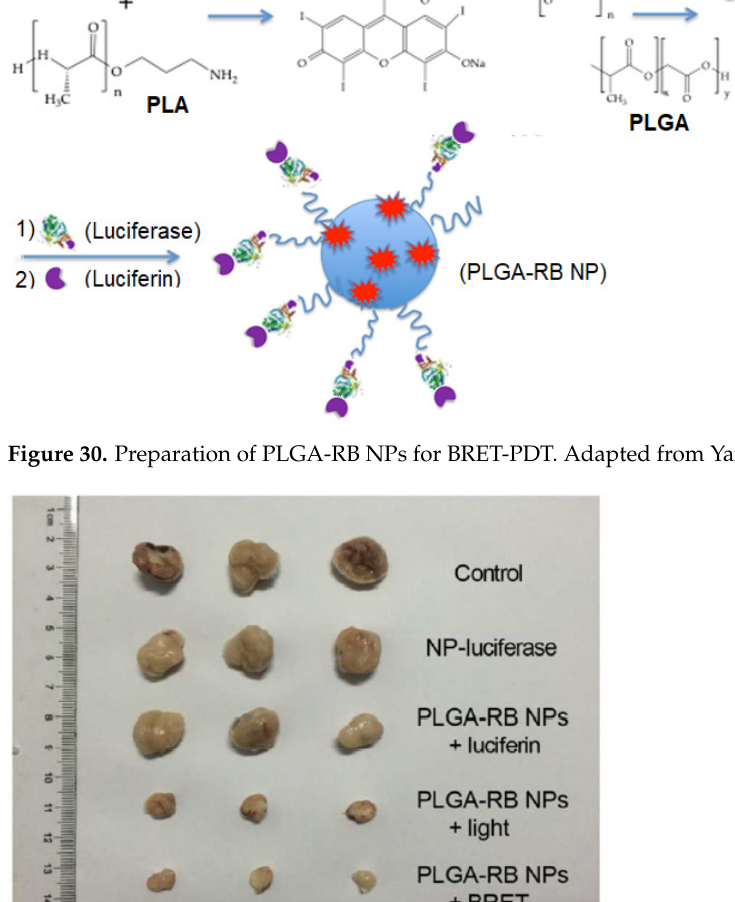
Figure 31. Photographs of tumors excised from the BRET-PDT treatment group and other groups on day 14 following laser irrdiation (520 nm, 200 mW/cm 2 , 30 min). Reprinted with the permission from Yang et al. [73]. Copyright 2018 American Chemical Society.